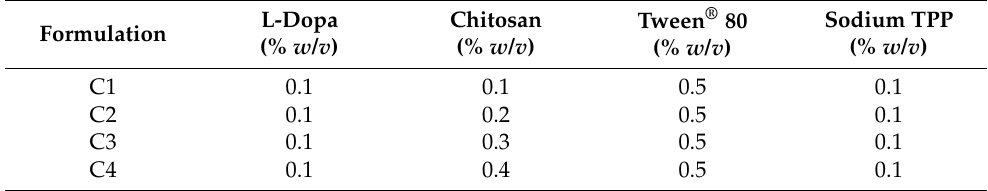
Figure 1. ( a ) Schematic illustrating how L-Dopa loaded PLGA nanoparticles were prepared via water-in-oil-in-water (W/O/W) modified solvent evaporation technique. ( b ) Schematic illustrating how L-Dopa loaded PLGA nanoparticles were prepared via ionic gelation. Table 2. Formulation composition of L-Dopa loaded chitosan